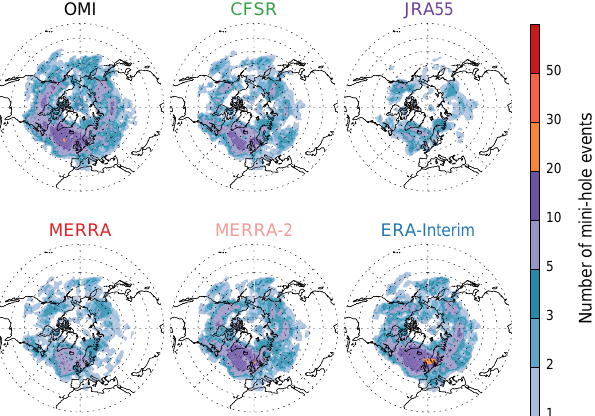
Figure 5. Geographical distribution of mini-hole events during 2005–2014 as found in OMI and reanalysis fields. Red/blue indi- cate relatively high/low number of events counts.